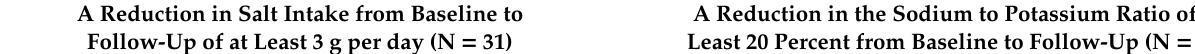
Table 5. Subgroup analyses of changes in cardiovascular risk factors among participants with per protocol changes in salt intake and salt / potassium ratio (participants 18 +